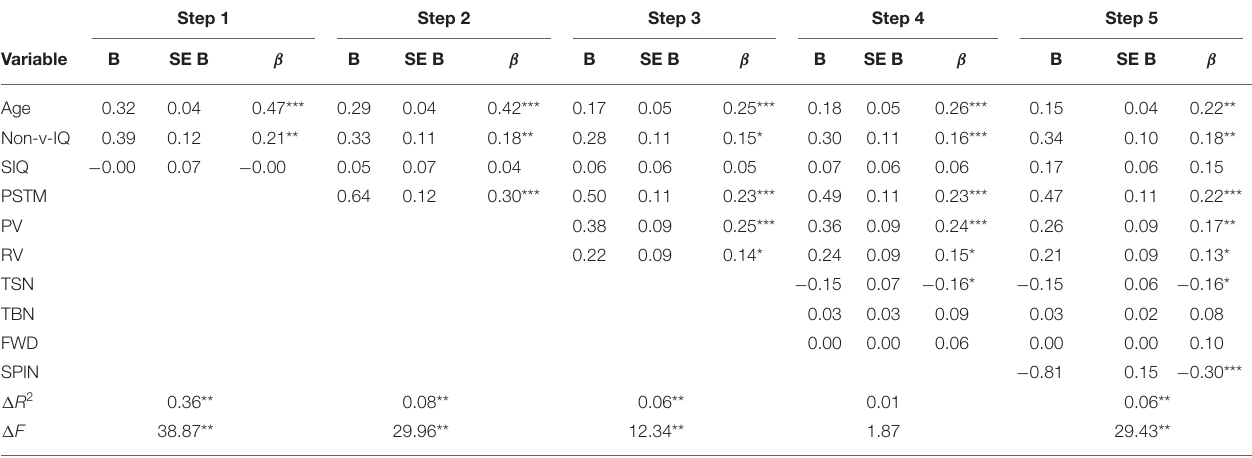
TABLE 3 | Summary of hierarchical linear regression analysis for predicting narrative language comprehension ability in children with developmental language disorder, using the predictors phonological short-term memory, vocabulary, tone-perception ability, and speech perception in quiet and